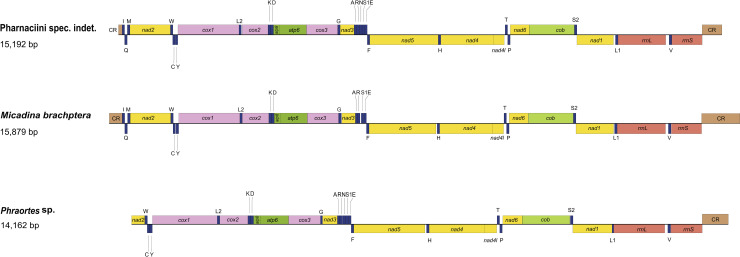
The structures of the mitochondrial genomes of Pharnaciini spec. indet., Micadina brachptera and Phraortes sp.The abbreviations of mitochondrial gene names are following those in MITOS webserver. The detailed annotations of the mitochondrial genomes are shown in S4 Table.